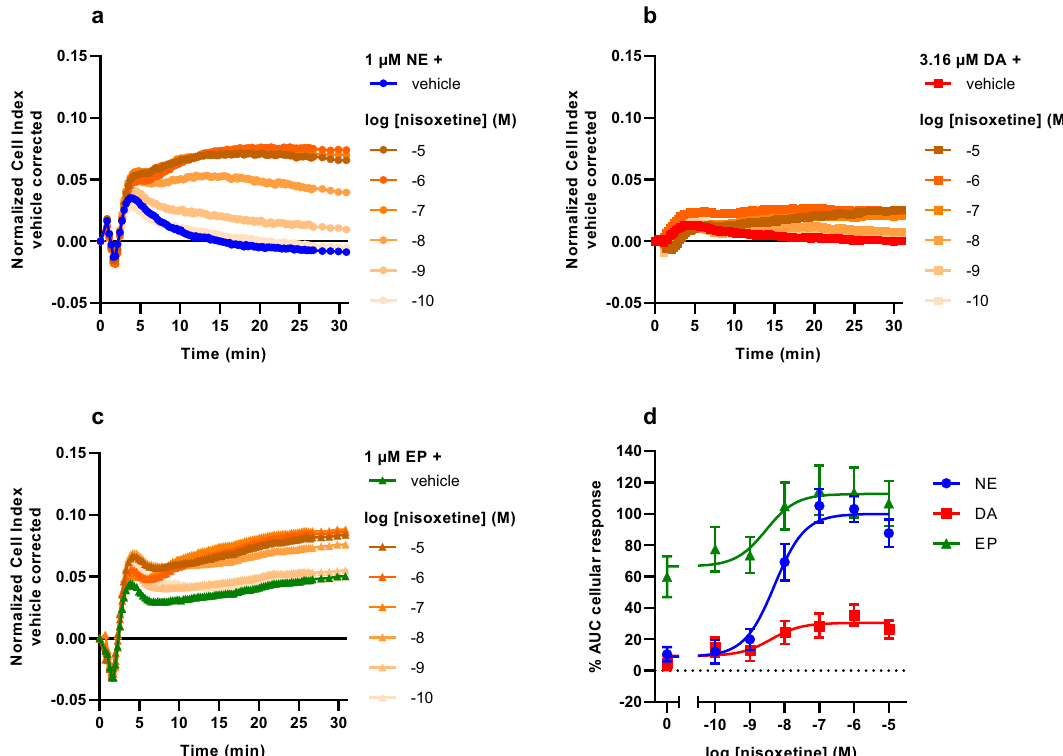
Figure 5. Nisoxetine potentiates substrate-induced cellular response in dox-treated JumpIn-NET cells in the TRACT assay. Representative vehicle-corrected normalized Cell Index traces are shown of dox-treated cells pretreated for 1 h with increasing concentrations of nisoxetine (orange), stimulated with a submaximal (EC 20 ) concentration of ( a ) norepinephrine (NE, 1 µM; circle), ( b ) dopamine (DA, 3.16 µM; square), or ( c ) epinephrine (EP, 1 µM; triangle). ( d ) Combined concentration-inhibition curve of nisoxetine upon stimulation with either NE, DA or EP. Cellular response is expressed as the net AUC of the first 30 min after stimulation. To demonstrate the assay window for each substrate, data are normalized to the response of 1 µM NE in the presence of 1 µM nisoxetine (set at 100%) and the vehicle response (set at 0%). Data are shown as mean ± SEM of four to seven individual experiments performed in